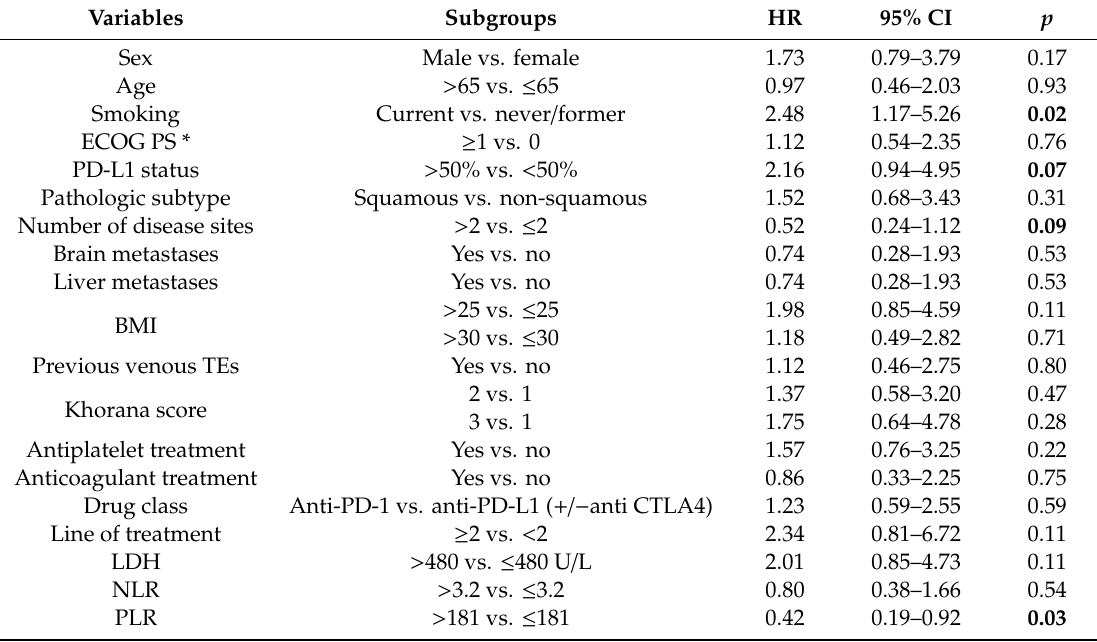
Table3. UnivariateanalysesofTEeventspecifichazardsaccordingtopatientsandtreatmentcharacteristics.